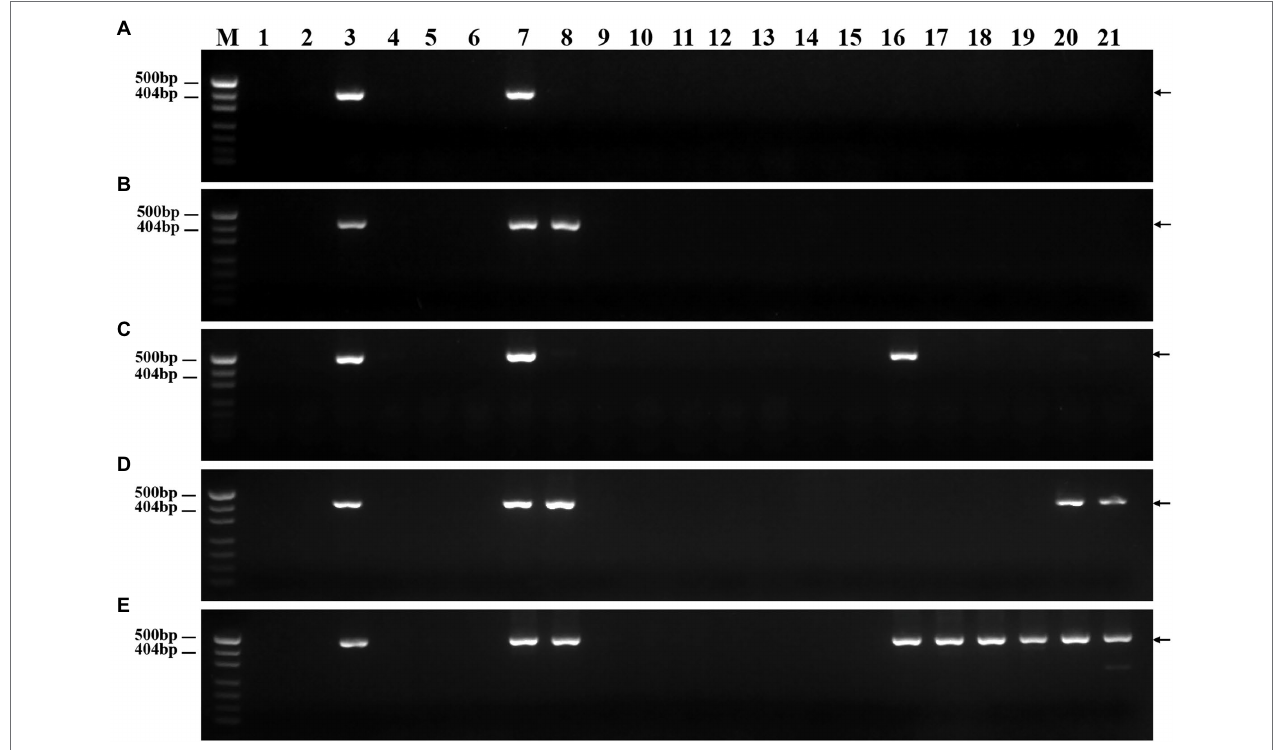
FIGURE 7 | Specificity and stability of specific molecular markers in other wheat-related species. (A) PH7Ns-15, (B) PH7Ns-43, (C) PH7Ns-12, (D) PH7Ns-14, and (E) PH7Ns-5. M: Marker (500 bp); 1: CS; 2: CS ph2b ; 3: DT23 (wheat- P. huashanica ditelosomic addition line); 4: T. urartu ; 5: Ae. speltoides ; 6: Ae. tauschii ; 7: P. huashanica ; 8: P. juncea ; 9: S. cereale ; 10: H. vulgre ; 11: Ag. cristatum ; 12: Das. villosum ; 13: Pse. libanotica ; 14: Th. elongatum ; 15: Th. bessarabicum ; 16: L. racemosus ; 17: L. secalinus ; 18: L. coreanus ; 19: L. multicaulis ; 20: L. arenarius ; and 21: L. cinereus . Arrows show the diagnostic amplification products of P. huashanica 7Ns chromosome.